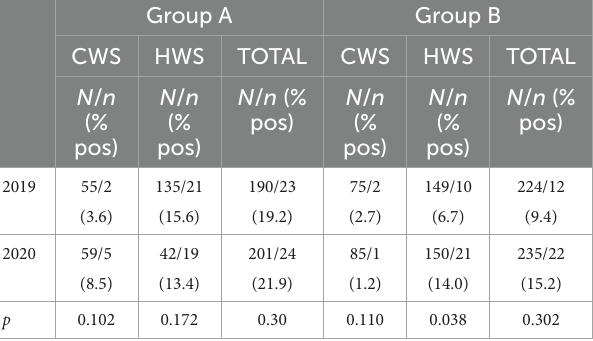
TABLE 2 Number of samples (N), number of positive samples ( n ), proportion of positive samples (% pos) per Group (A, B) and year (2019, 2020), and p values (CWS = Cold Water System; HWS = Hot Water System).